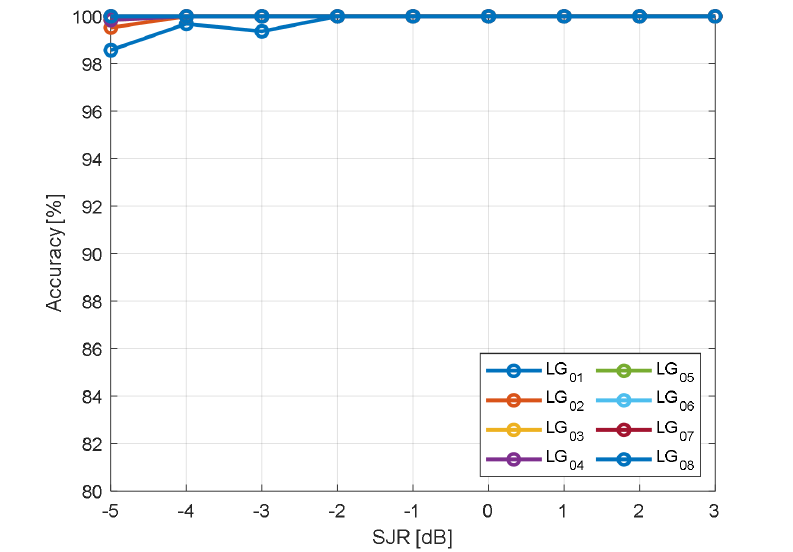
Figure 8. Block diagram of the proposed algorithm for light beam mode classification.